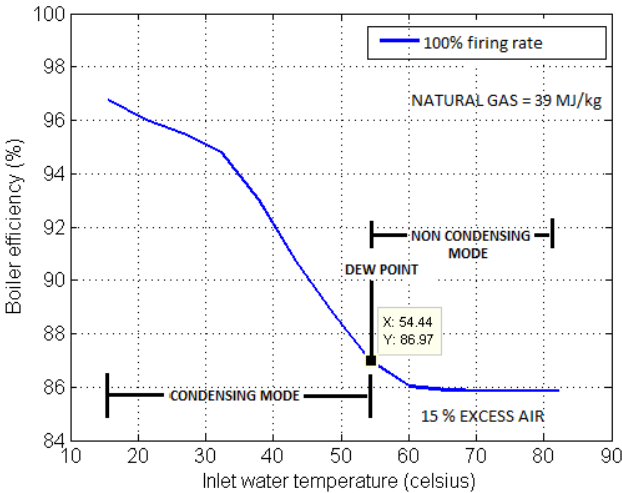
Figure 4. Effect of return (inlet) water temperature on efficiency of condensing